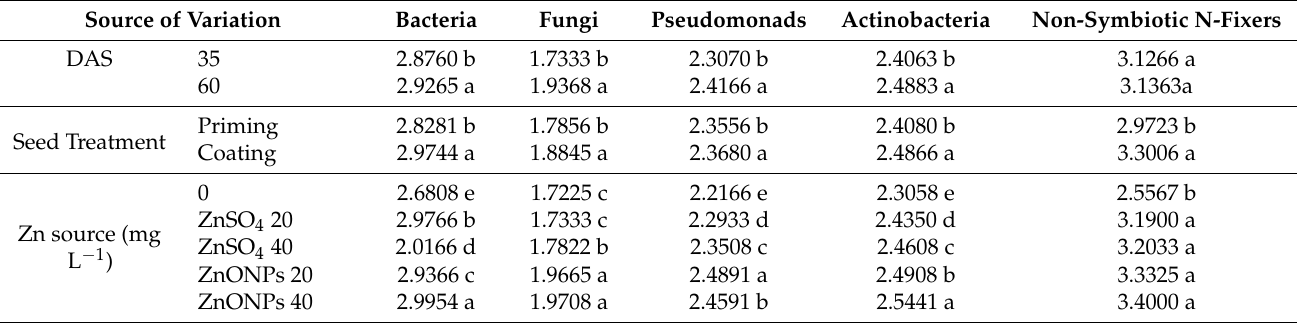
Table 8. Effects of time duration (DAS) and seed treatment with various concentrations of ZnONPs on viable cell count